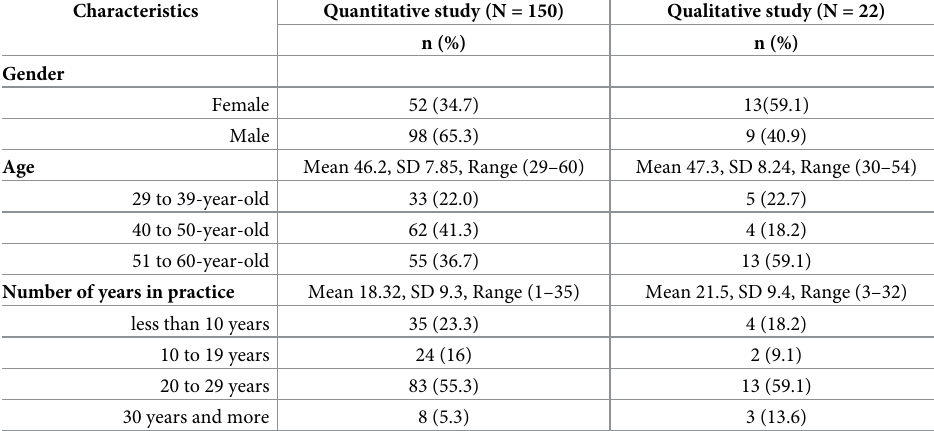
Table 1. Characteristics of study population: Primary care